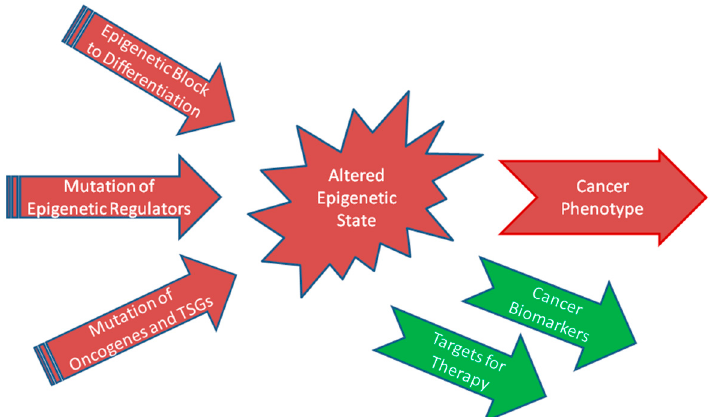
Figure 1. Three factors establishing the altered epigenetic states of (urological) cancers and their consequences. TSGs, tumor suppressor genes.